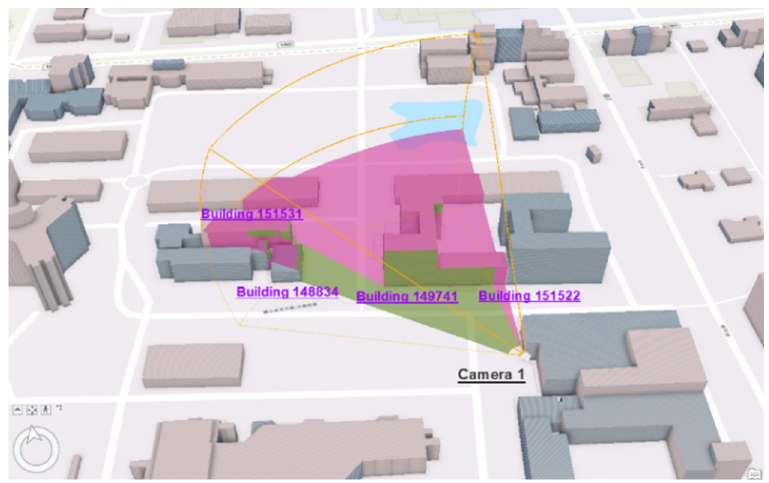
Figure 11. 3D FOV analysis of a single CCTV.